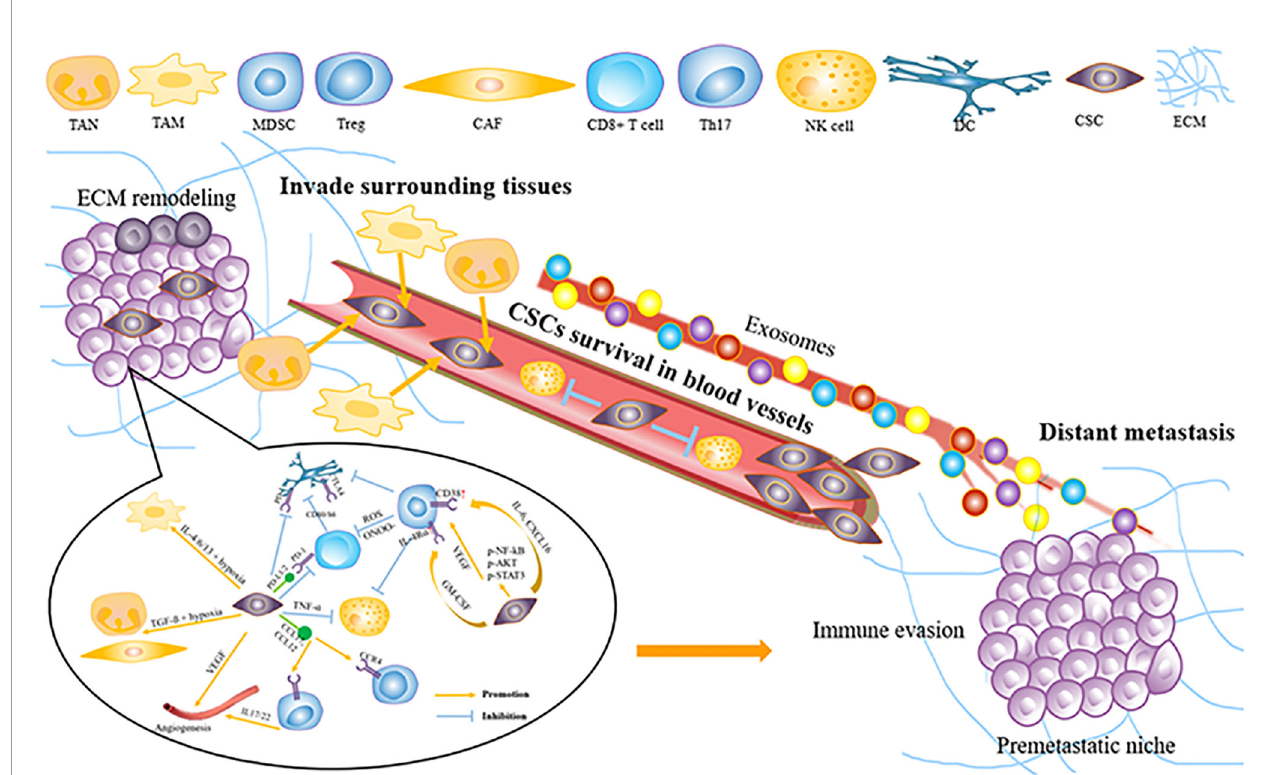
FIGURE 2 | How tumor microenvironment support ESCC invasion and metastasis. ESCC, esophageal squamous carcinoma; MD.SC, man-our-derived suppressor cell; DC, dendritic cell; Treg, regulatory T cell; CAE, Cancer associated fi broblast; VEGF, vascular endothelial growth factor; NK cell, natural killer cell; TAM, tumor- associated macrophage; TAN, tumor-related neutrophil; ECM, extracellular matrix; CSCs, cancer Stem